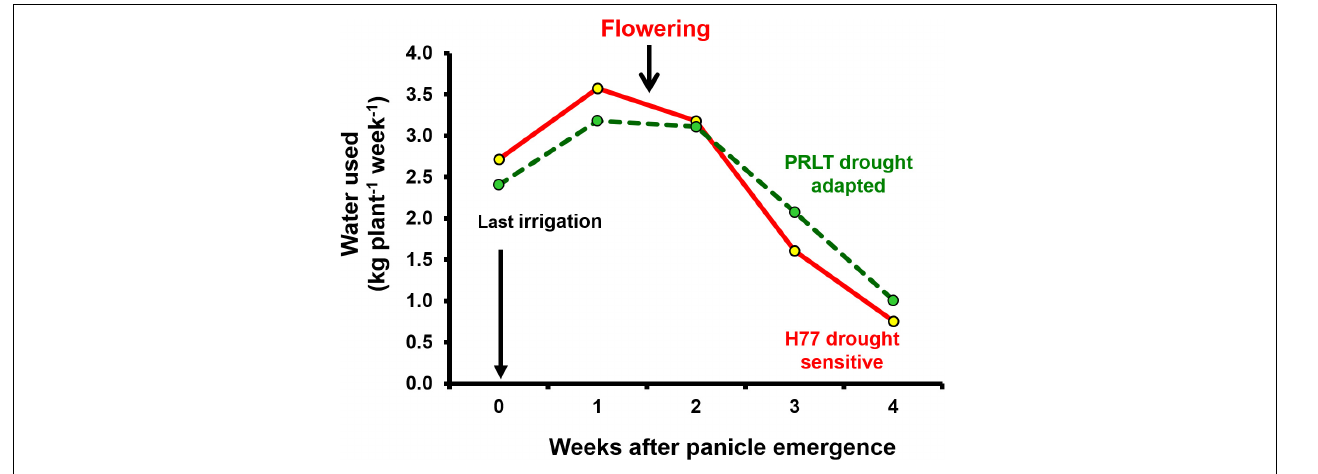
FIGURE 2 | Water extraction pattern in H77 and PRLT before and after flowering under water deficit conditions (adopted from Vadez et al., 2013).